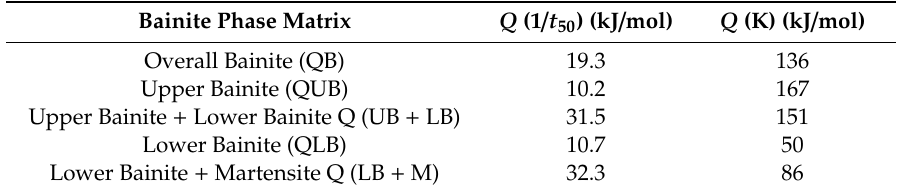
Table 6. Bainite reaction activation energy calculation based on 1 / t 50 and K as reaction